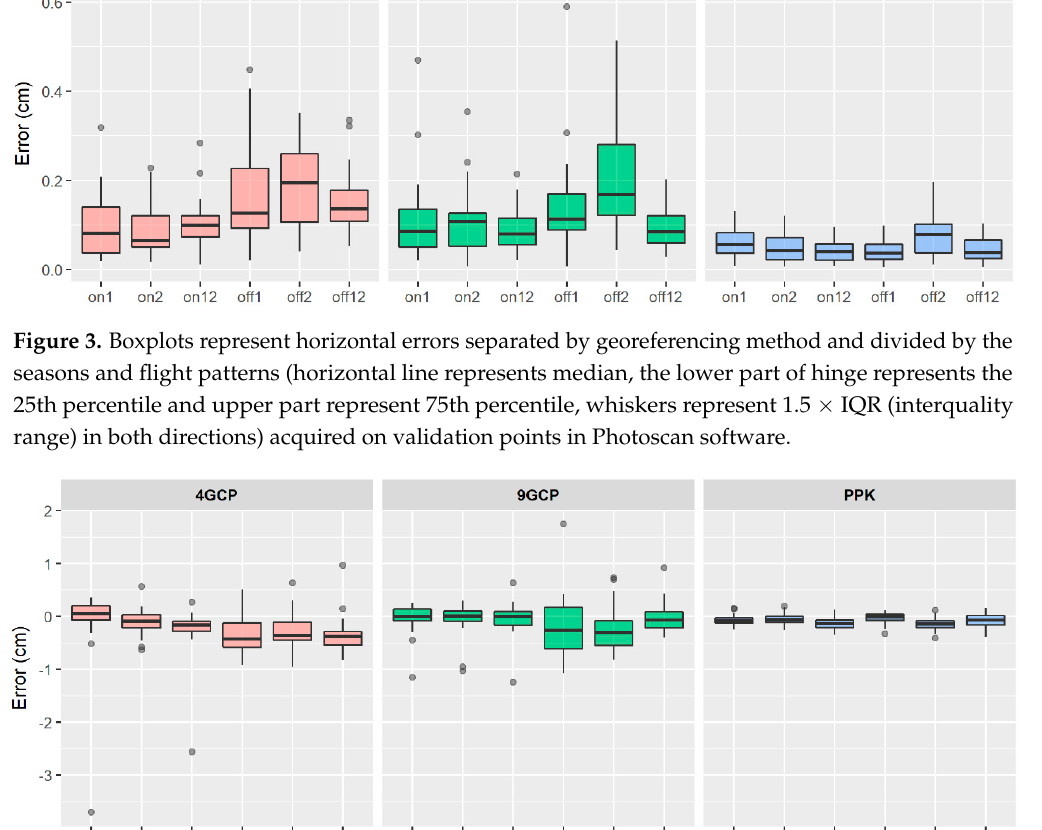
Figure 4. Boxplots represent horizontal errors separated by georeferencing method and divided by the seasons and flight patterns (horizontal line represents median, the lower part of hinge represents the 25th percentile and upper part represent 75th percentile, whiskers represent 1.5 × IQR (interquality range) in both directions) acquired on validation points in Photoscan software.